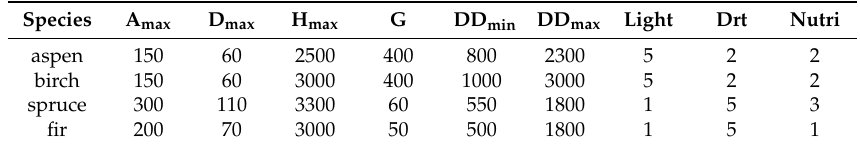
Table 2. Input parameters of growth and environmental response of dominant tree species used in the ZELIG simulation.